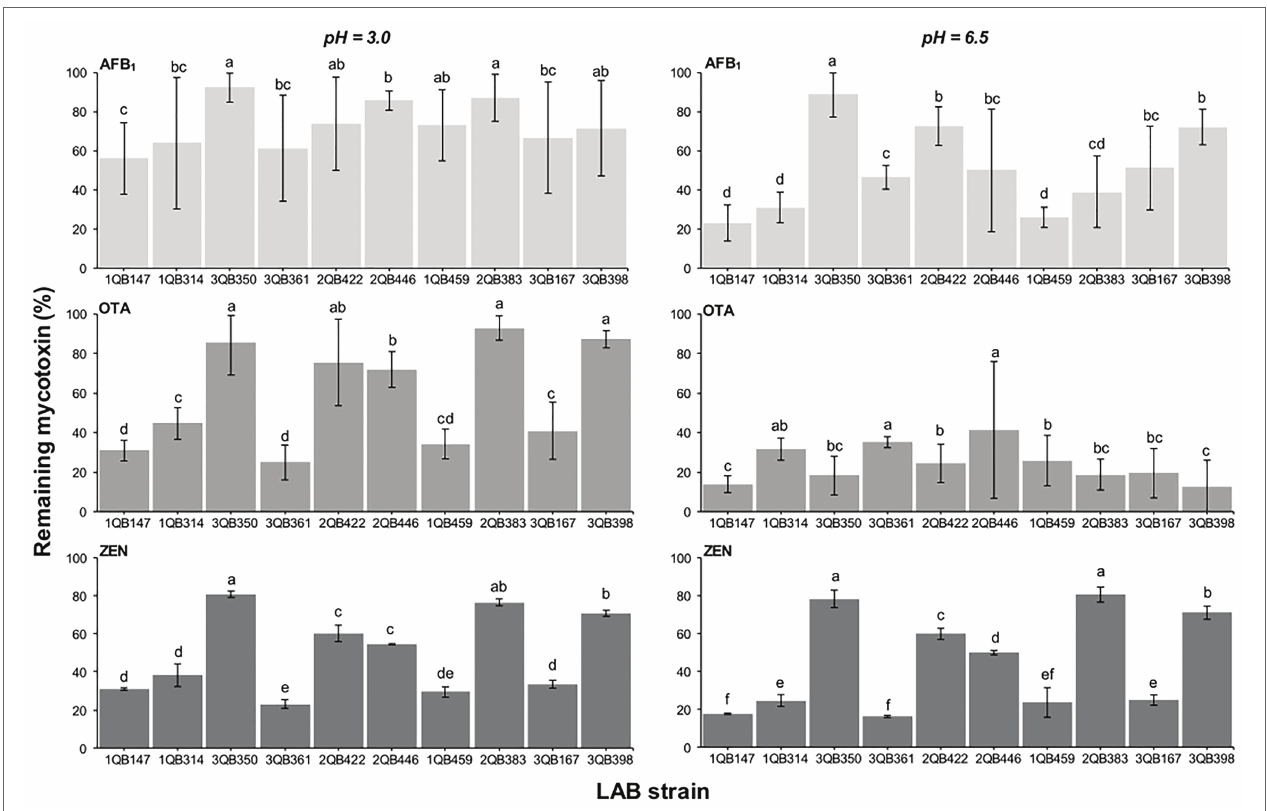
FIGURE 7 | Remaining AFB 1 , OTA, and ZEN in PPB at pH 3.0 and 6.5, after 5 min contact time with heat-inactivated LAB strains including: four strains of Lactiplantibacillus plantarum (former Lactobacillus plantarum , comprising strains 1QB147, 1QB314, 3QB350, and QB361), two strains of Levilactobacillus brevis (former Lactobacillus brevis , comprising strains 2QB422 and 3QB446), and four strains of Levilactobacillus spp. (former Lactobacillus sp., comprising strains 1QB4593, 2QB383, 3QB167, and QB398). Initial concentrations of mycotoxins in PPB were 1.0 μ g ml −1 (AFB 1 , OTA) and 2.0 μ g ml −1 (ZEN). Results (% in relation to controls) are expressed as mean values of three independent experiments, with SDs indicated as error bars. Bars with no common letters differ significantly ( p <